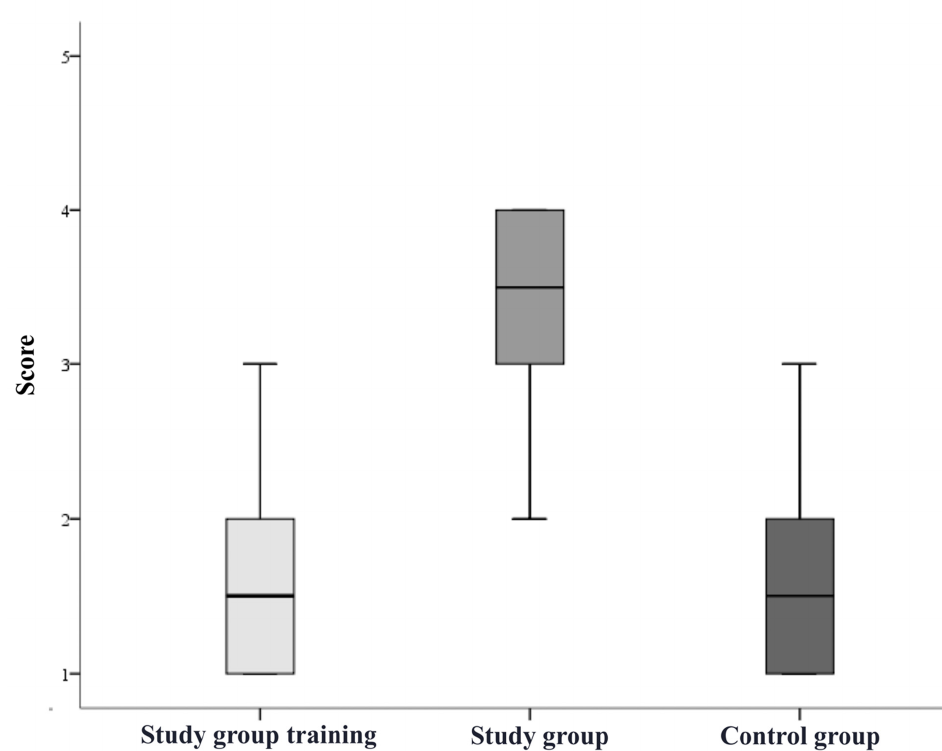
Figure 6. Grading of catheter handling. Legend: score range 1–5.